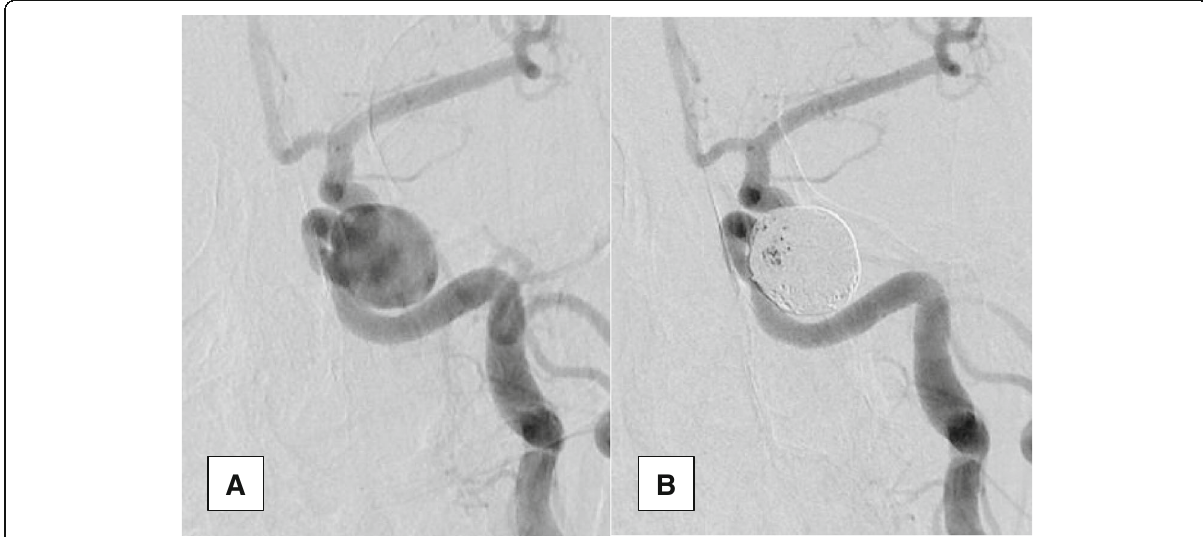
Fig. 3 Carotid cavernous aneurysm before ( a ) and after ( b ) coiling. Residual aneurysm with contrast within coil interstices is noticed (class IIIa